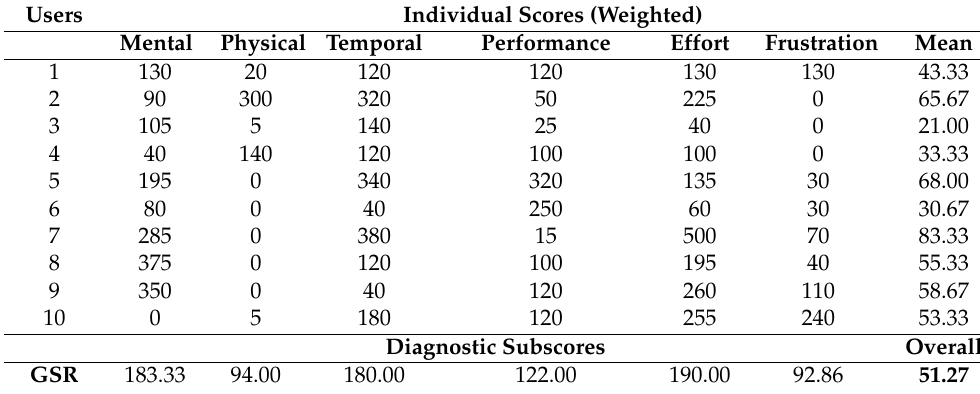
Table 3. NASA-TLX results for Task 2.